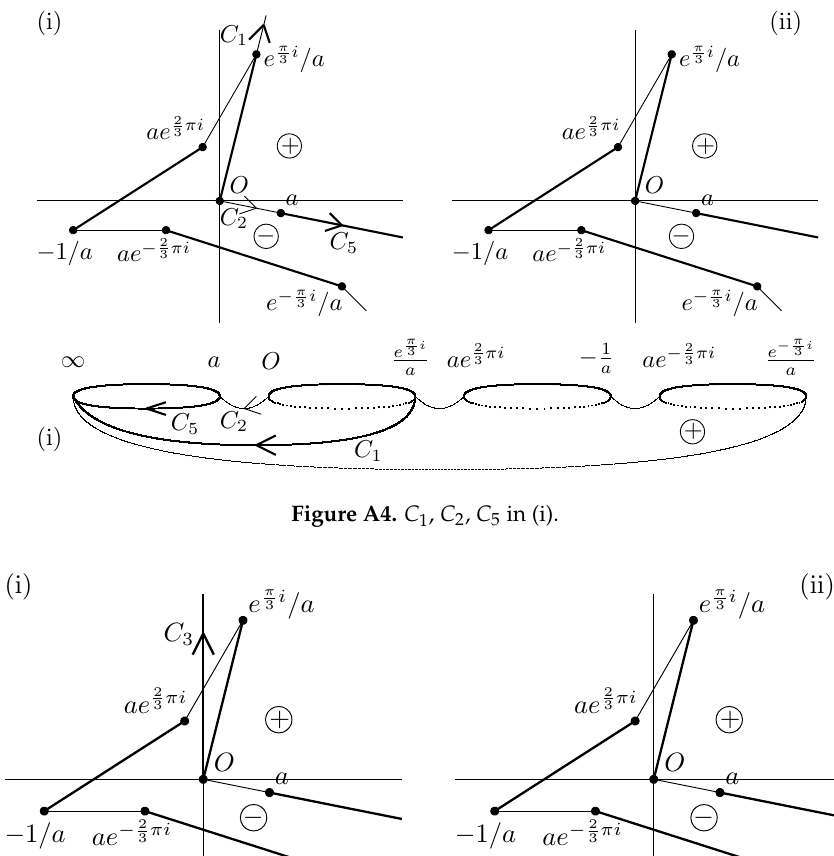
Figure A4. C 1 , C 2 , C 5 in